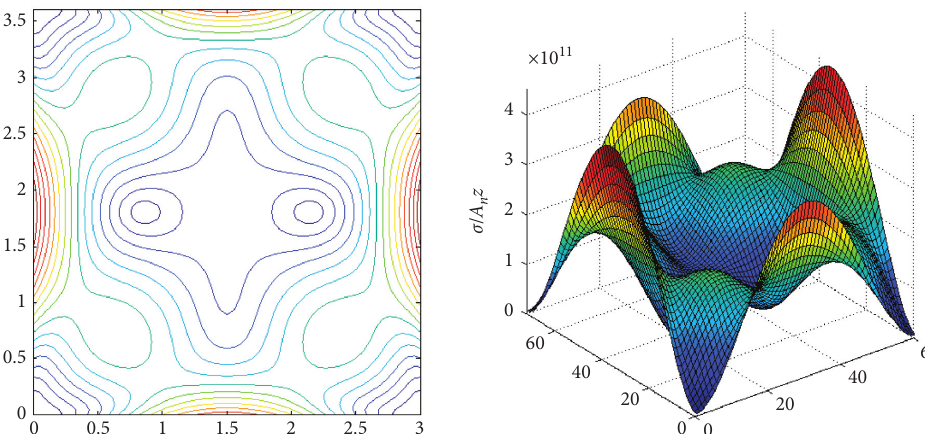
Figure 7: The maximum shear of 1 st order mode (C-C-C-C).